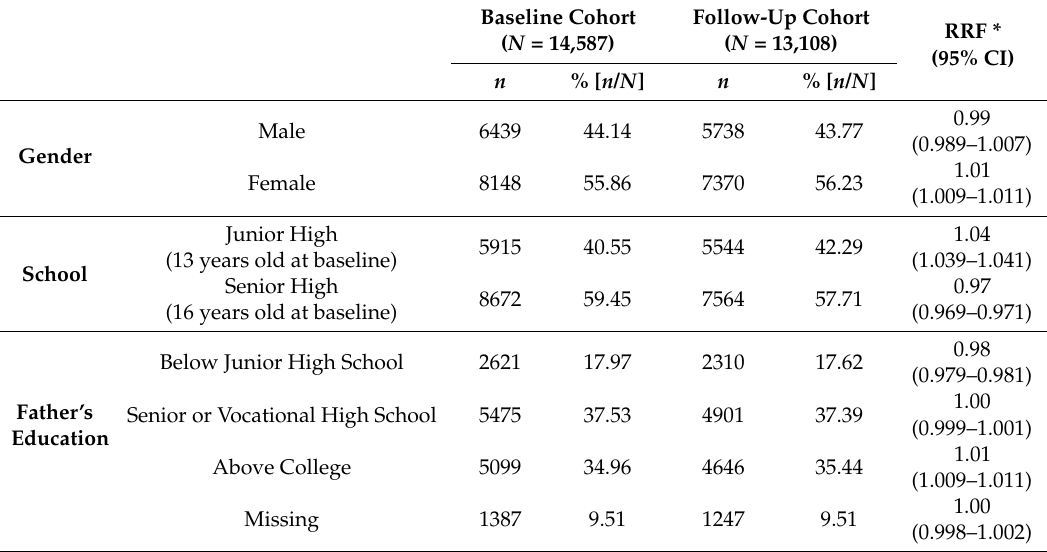
Table A1. Output of the attrition analysis performed on never smokers at baseline and at